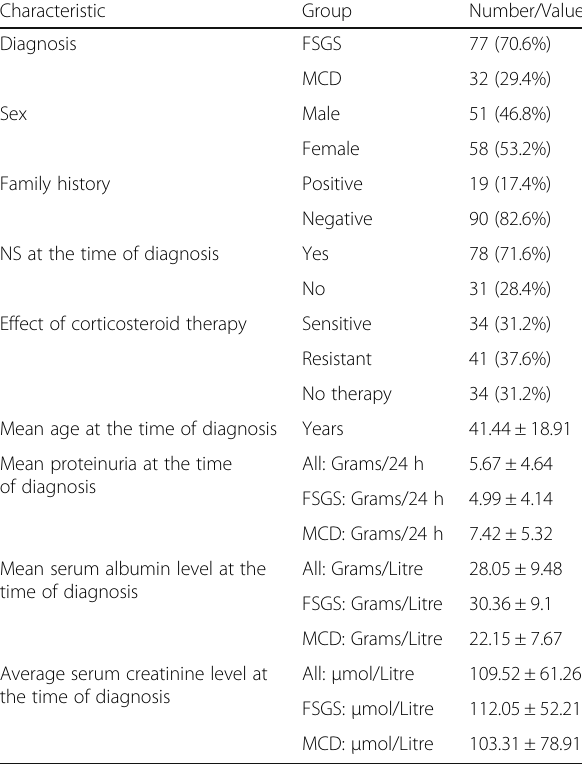
Table 1 Clinical data of 109 patients with FSGS/MCD